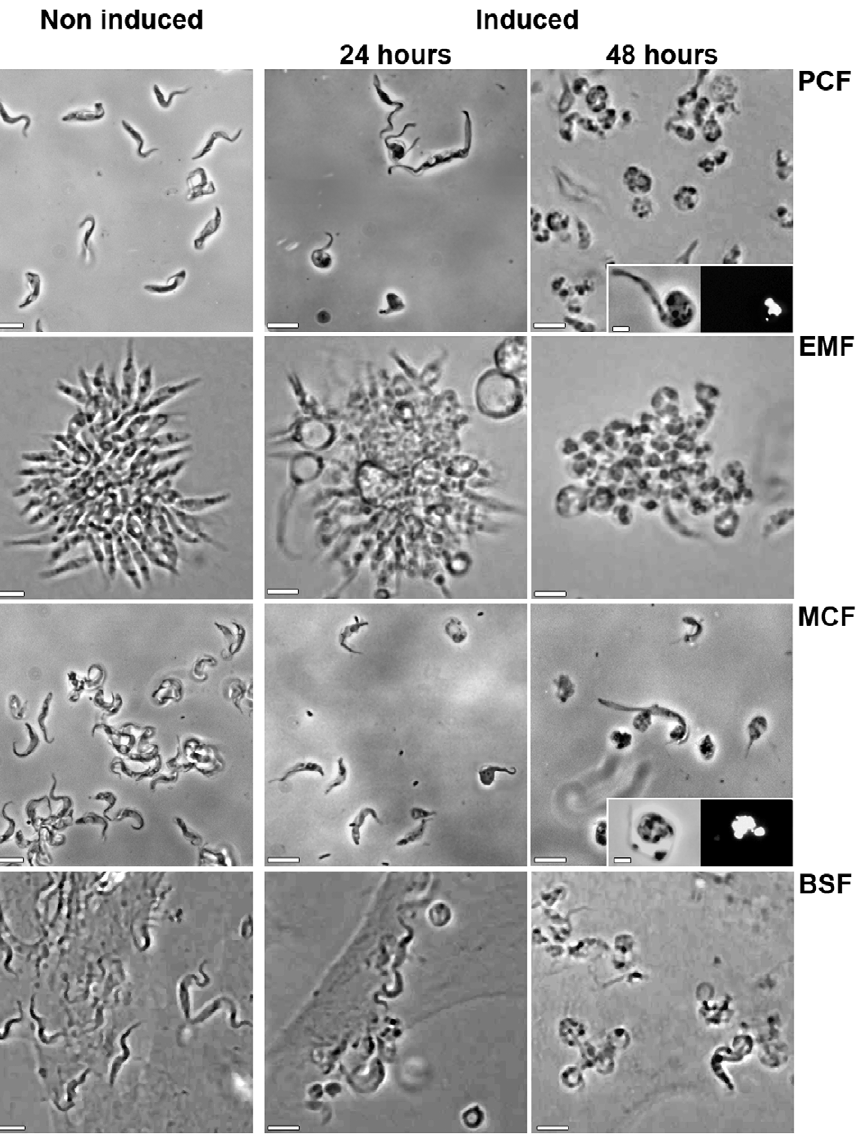
Figure 2. Inducible RNAi on tubulin genes through the T.congolense life cycle. Phase contrast microscope images of the in vitro cultivated IL3000:13–29 strain transfected with p2T7 Ti / a TUB vector in all the developmental stages. Non induced and tetracycline (1 m g/ml for 24 h and 48 h) induced cells are presented. PCF, EMF colonies, MCF (after DE52 purification) and BSF on BAE feeder cell layer were observed directly in the culture medium. In the insets, PCF and MCF were fixed and stained with 4,6-diamino-2-phenylindole (DAPI) before observation in phase contrast. Scale bars=10 m m.